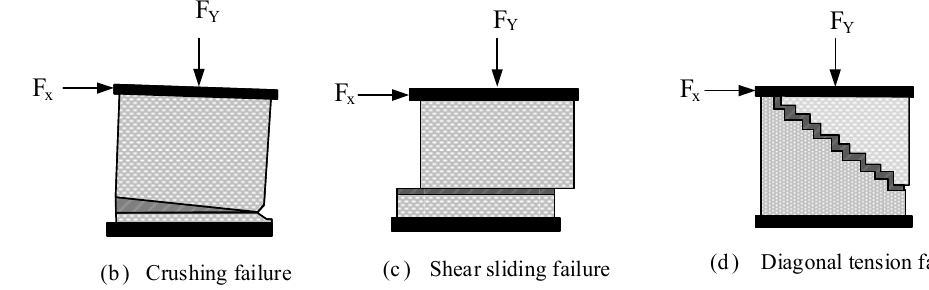
Figure 17. The FMs of masonry buildings under seismic excitations and masonry walls failed due to out-of-plane loading.